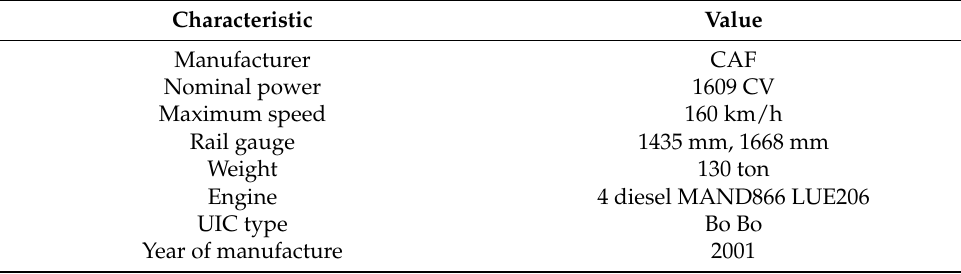
Figure 13. Map of the railway track Chiriguaná–Santa Marta. Table 3. CAF S-594-2 diesel–electric locomotive